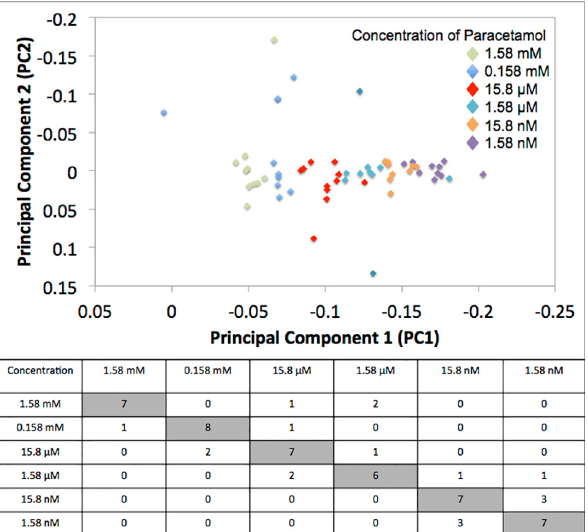
Fig 5. PCA scatter plot, PC2 vs. PC1, for analysis of varied concentrations of paracetamol on individual paper devices. Table shows the confusion matrix from PCA analysis of a limit of detection study of paracetamol on paper microfluidic devices. Numbers indicate the overlap of data points between each concentration studied.